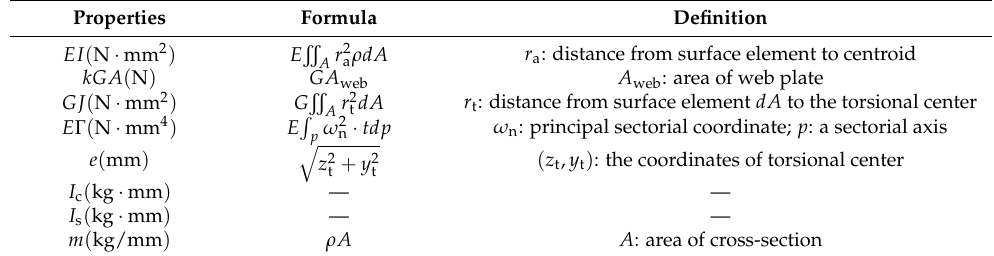
Table 5. Properties of I, box, open cross-sections.